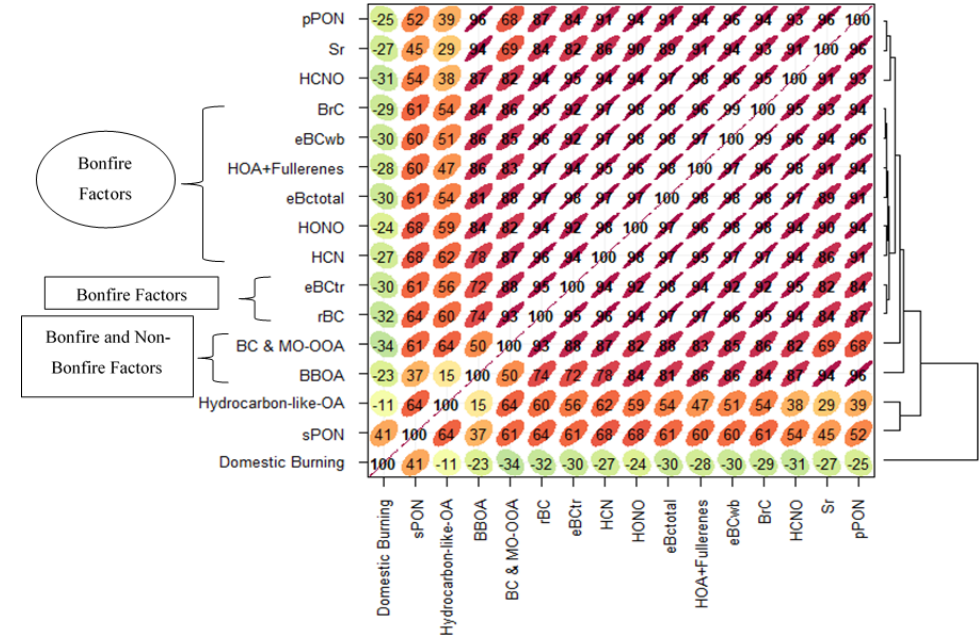
Figure 4. The similarity between different pollutant time series through hierarchical cluster analysis (HCA).